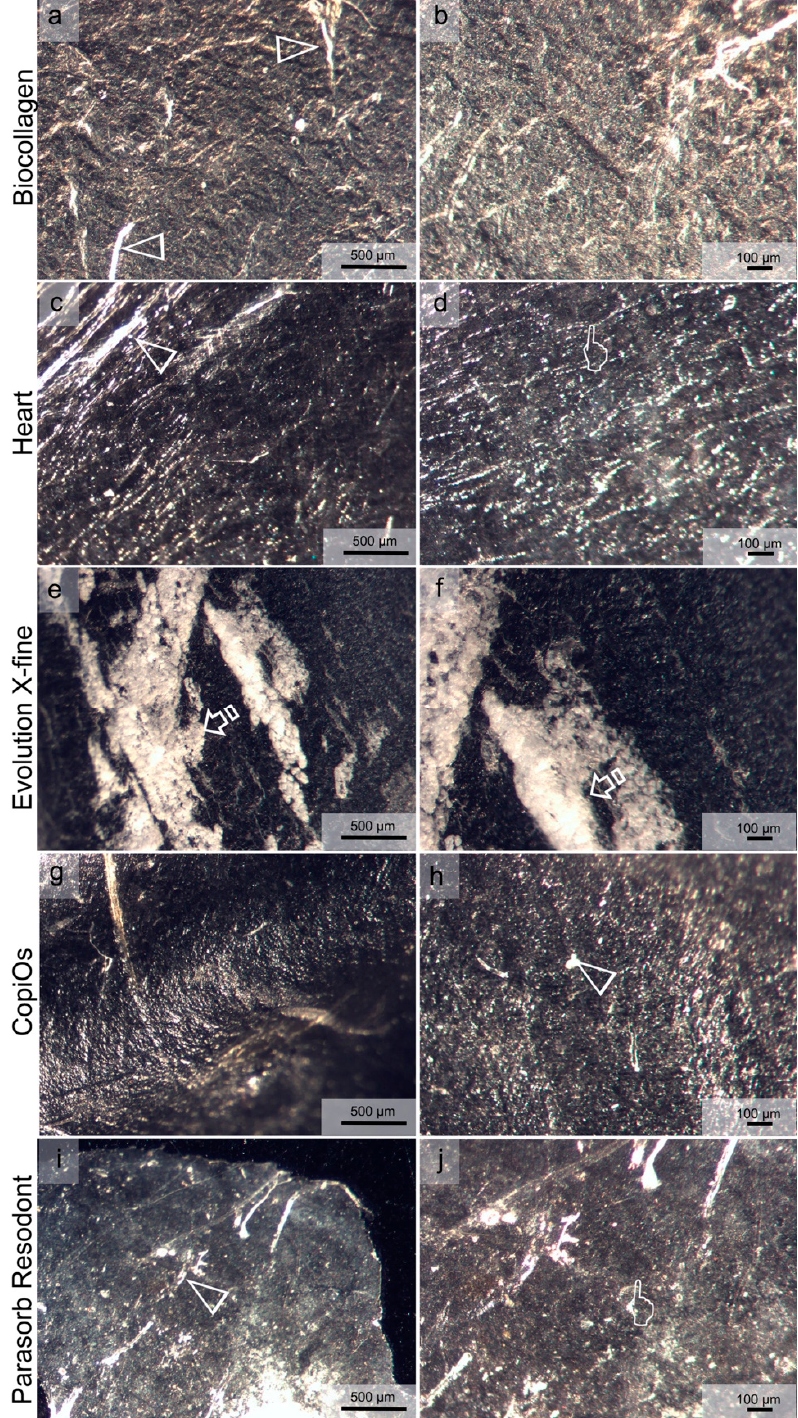
Figure 6. Light micrographs taken of membranes after immersion in the Trypsin degradation test. ( a ) Biocollagen surface at 60× magnification. ( b ) Biocollagen at 120× magnification. ( c ) Heart surface at 60× magnification. ( d ) Heart surface at 120× magnification. ( e ) Evolution X-fine surface at 60× magnification. ( f ) Evolution X-fine surface at 120× magnification. ( g ) CopiOs surface at 60× magnification. ( h ) CopiOs surface at 120× magnification. ( i ) Parasorb Resodont surface at 60× magnification. ( j ) Parasorb Resodont surface at 120× magnification. The scale bar is 500 μ m in ( a , c , e , g , i ), and 100 μ m in ( b , d , f , h , j ). Pointers indicate pores of different sizes across the membrane’s surface. Arrow heads indicate collagen fibers.